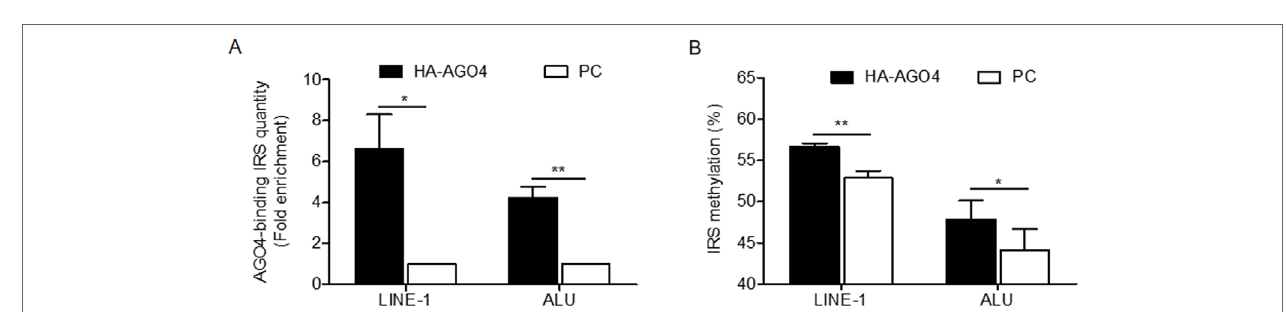
FIGURE 6 | AGO4 localization is involved in RdDM by introducing genomic DNA methylation in human cells. (A) ChIP experiments using a hemagglutinin (HA) antibody showed elevation of the levels of AGO4-binding LINE-1 or ALU found in AGO4-overexpressing cells compared with their control counterparts. (B) Moreover, the binding of the AGO4 protein to interspersed repetitive sequence increased DNA